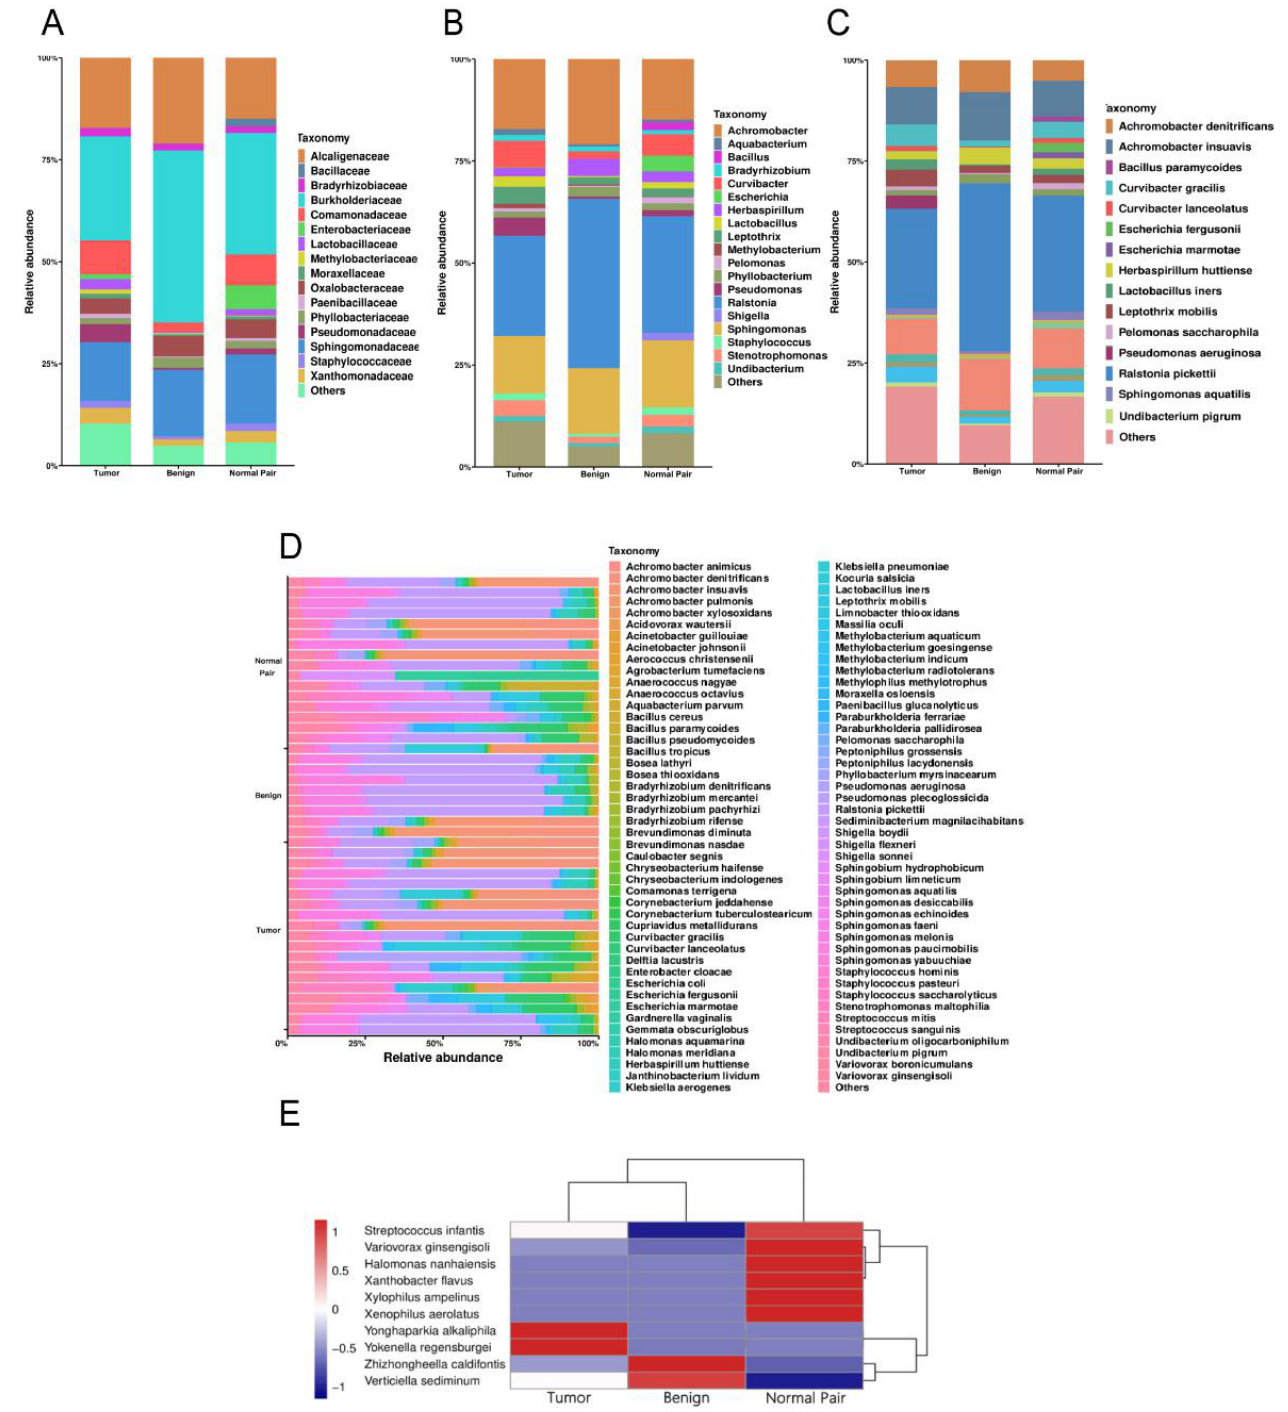
Figure 1. ( A ) Bar plots of the taxonomic profiles of the benign ( n = 8), normal pair ( n = 18), and breast tumor tissue ( n = 18) microbiota at the family level, ( B ) genus level, and ( C ) species level with a relative abundance >1% are shown. ( D ) Relative abundance of bacterial species within breast tissue samples across all tissues. Each bar represents a subject and each colored box a bacterial taxon, the height of each colored box represents the relative abundance of that organism within the sample. ( E ) A heatmap illustrates the cluster analysis of species abundance in each group. A blue color represents rare or absent species while a red color represents abundant species.